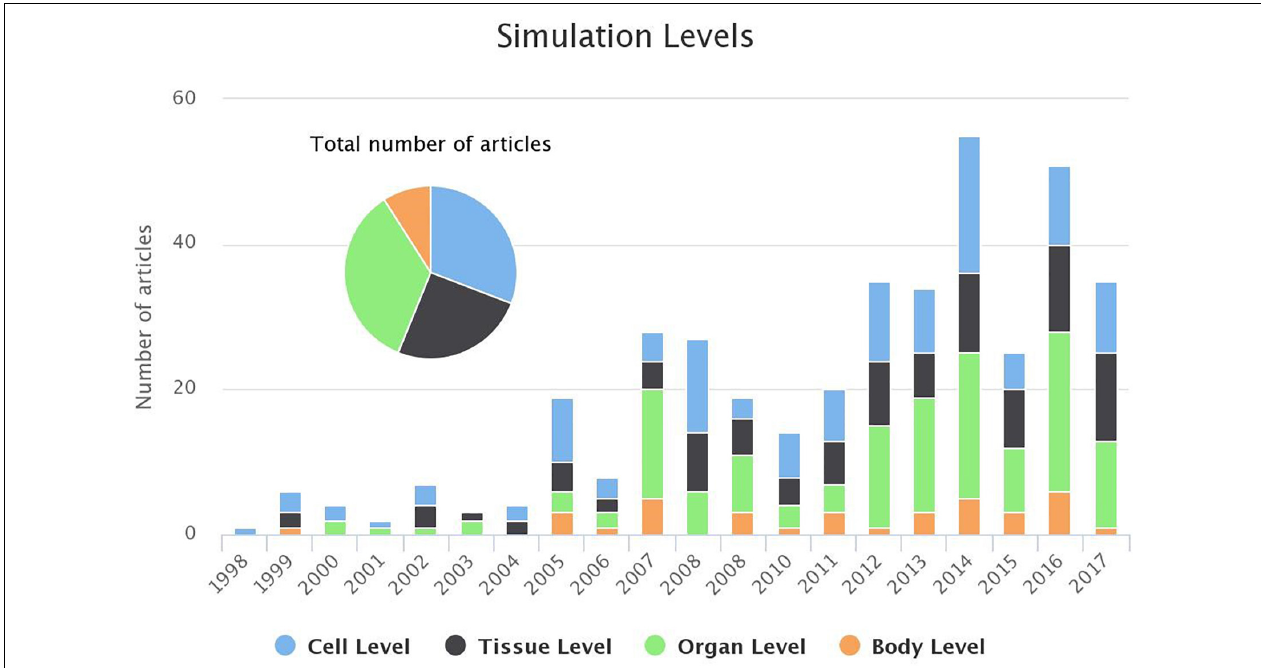
FIGURE 7 | Evolution of the number of studies focusing each of the simulation levels (bar chart) and the distribution of the studies for the last 20 years (pie chart). For 2018 1 study targeted cell level and 2 studies the tissue level (until 1st of March